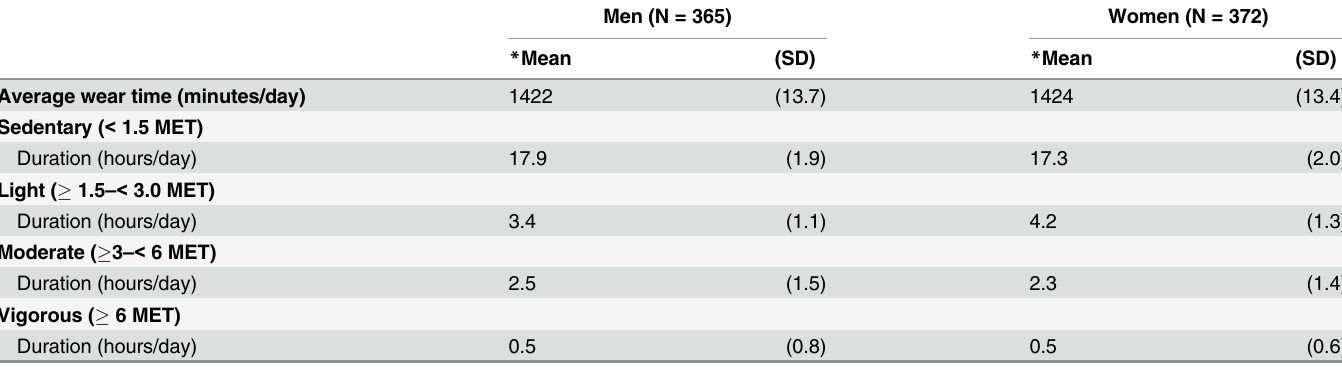
Table 2. Average daily duration of physical activity among 737 men and women during a five day